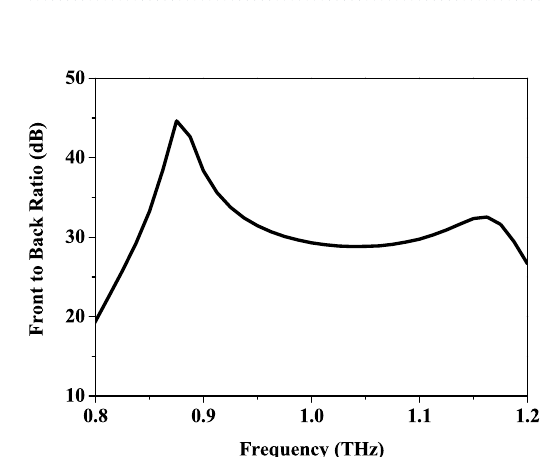
Figure 5. Simulated front-to-back ratio of the proposed antenna element.